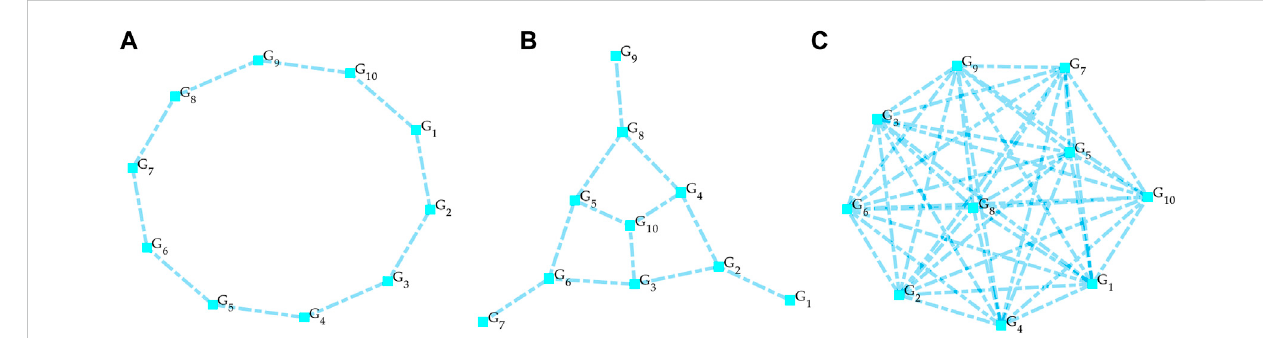
FIGURE 3 Communication network of ten regulation resources for the DT-DPT system. (A) Ring network. (B) Local connected network. (C) Fully connected